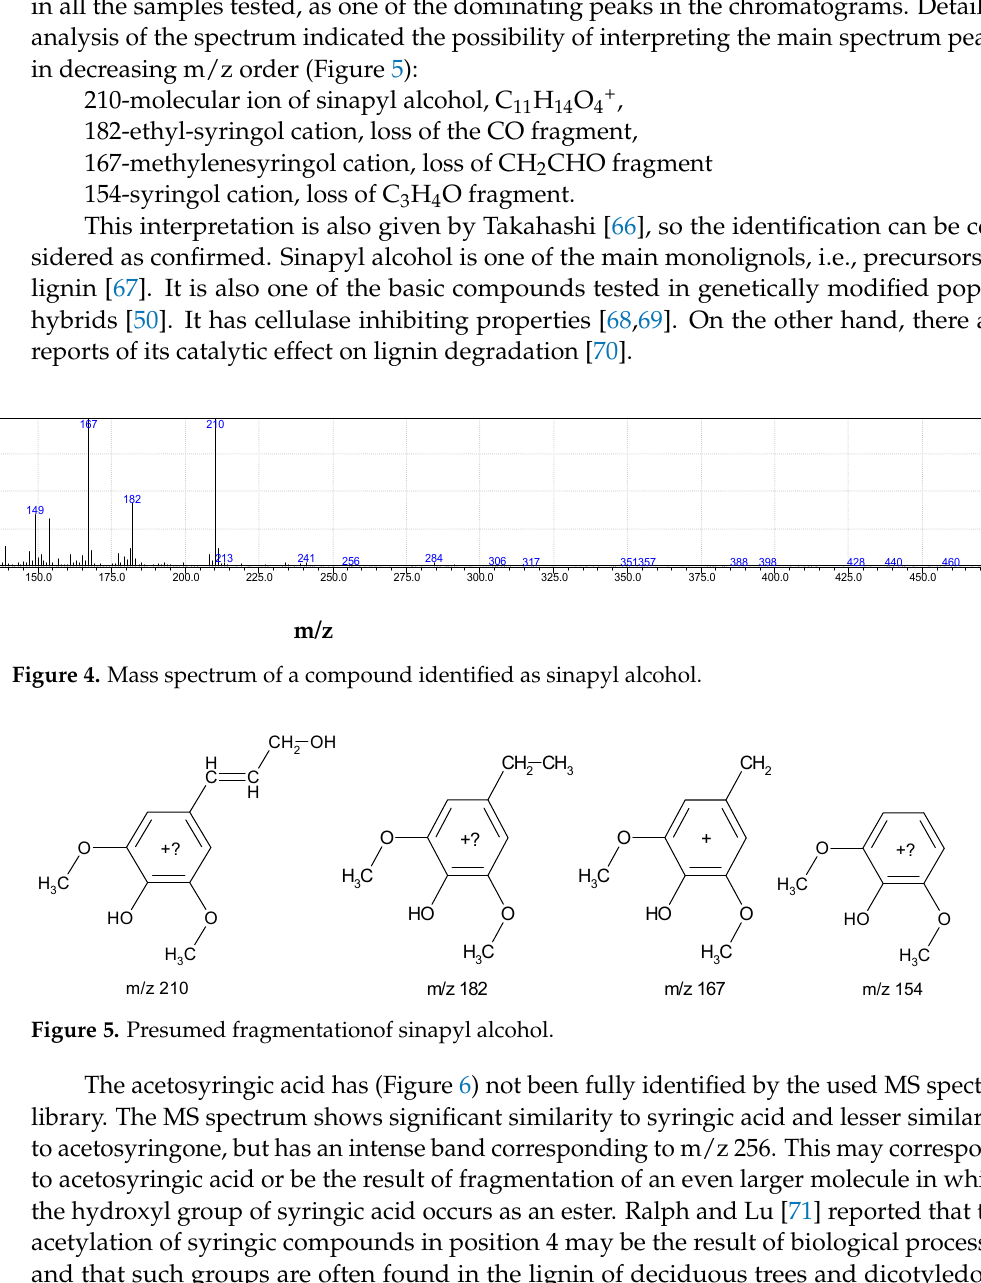
Figure 6. Mass spectrum of the compound identified as probably syringic acid acetate.